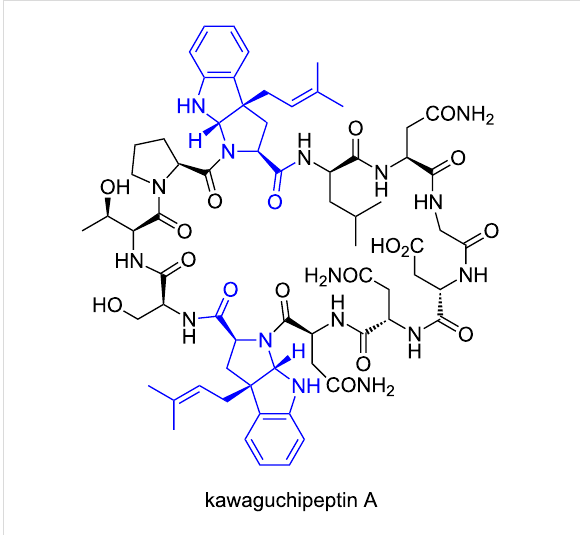
Figure 6: Chemical structure of kawaguchipeptin A. Dimethylallylated tryptophan residues are colored